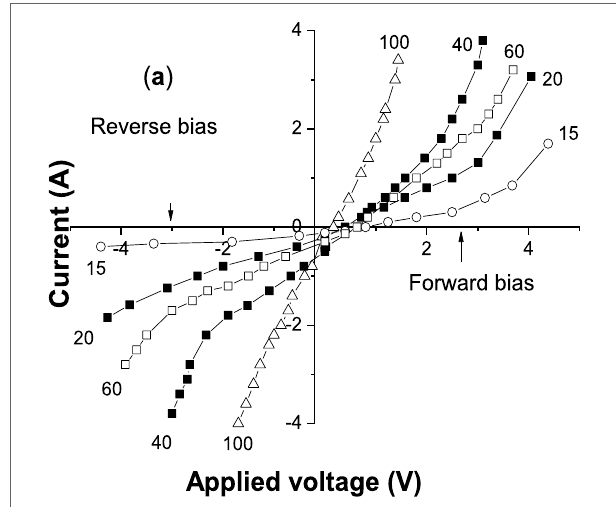
FiGURe 5 | The device I – V measured for the SJFC devices with various compositions under applied bias voltages . wt% represents the percentage of NSDC in NSDC–LCN composite, wt = 16, 20, 40, 60, 100. [Permission from Zhu et al. (2015). Available from: http://onlinelibrary.wiley.